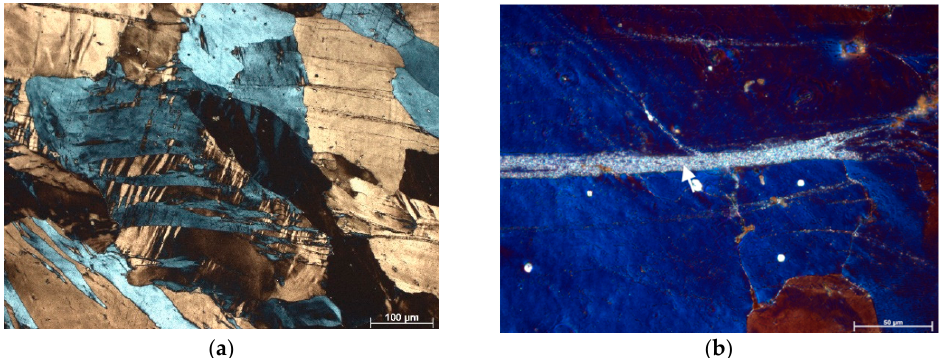
Figure 4. Microstructures of the AlMg5 samples ( a ) ST + ECAP 2× +ageing 160 °C for 4 h, ( b ) ST + ECAP 2× + ageing 180 °C for 4 h.